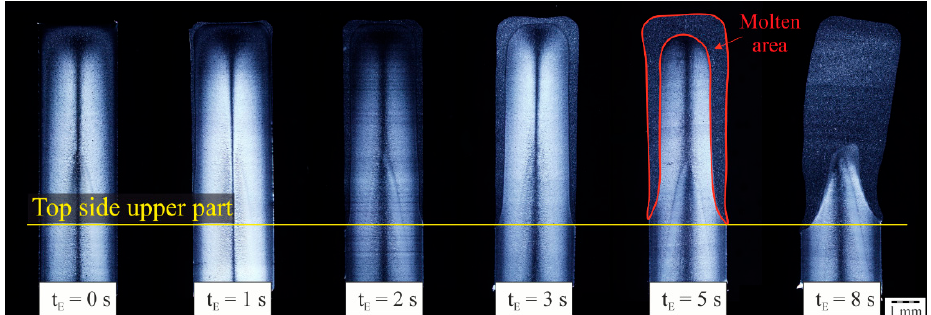
Figure 3. Melt formation shown by thin sections of the rivet pin for different heating times (transmitted-light microscopy). Process parameters: material polypropylene (PP), diameter rivet pin